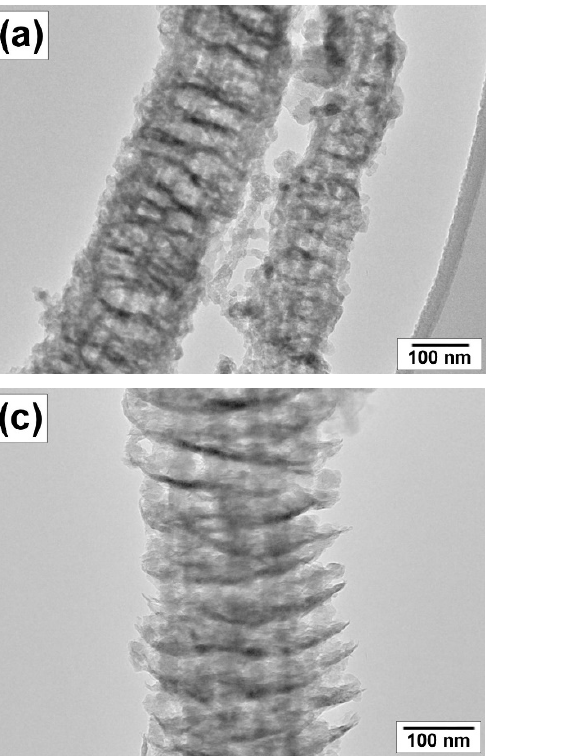
Figure 12. SEM ( a , b ) and TEM ( c , d) images of the carbon product obtained by the decomposition of TCE at 600 °C over catalysts: ( a , c ) 100Ni; ( b , d ) 96Ni-4W. High-resolution TEM images show in more detail the morphology of the carbon nanomaterials (Figure 13). It can be seen that both samples are represented by alternating graphene packets of different densities. The diameter of the fibers ranges from 100 to 250 nm.